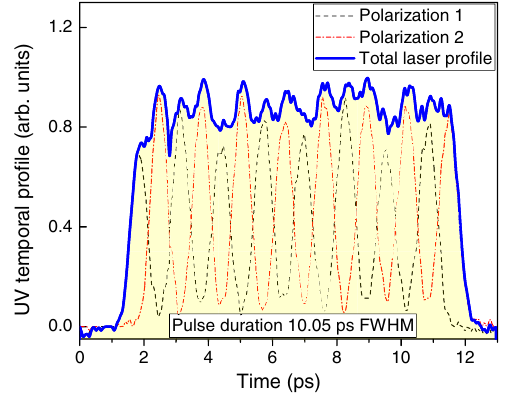
FIG. 4. Longitudinal pulse profile of the Ti ∶ sapphire laser, measured with cross-correlation in the UV. The profile is obtained by pulse stacking with four crystals, resulting in 16 pulse replicas. The cross-correlations for s- and p-polarized pulses are done in sequence (black and red curves) and summed up numerically (blue curve).